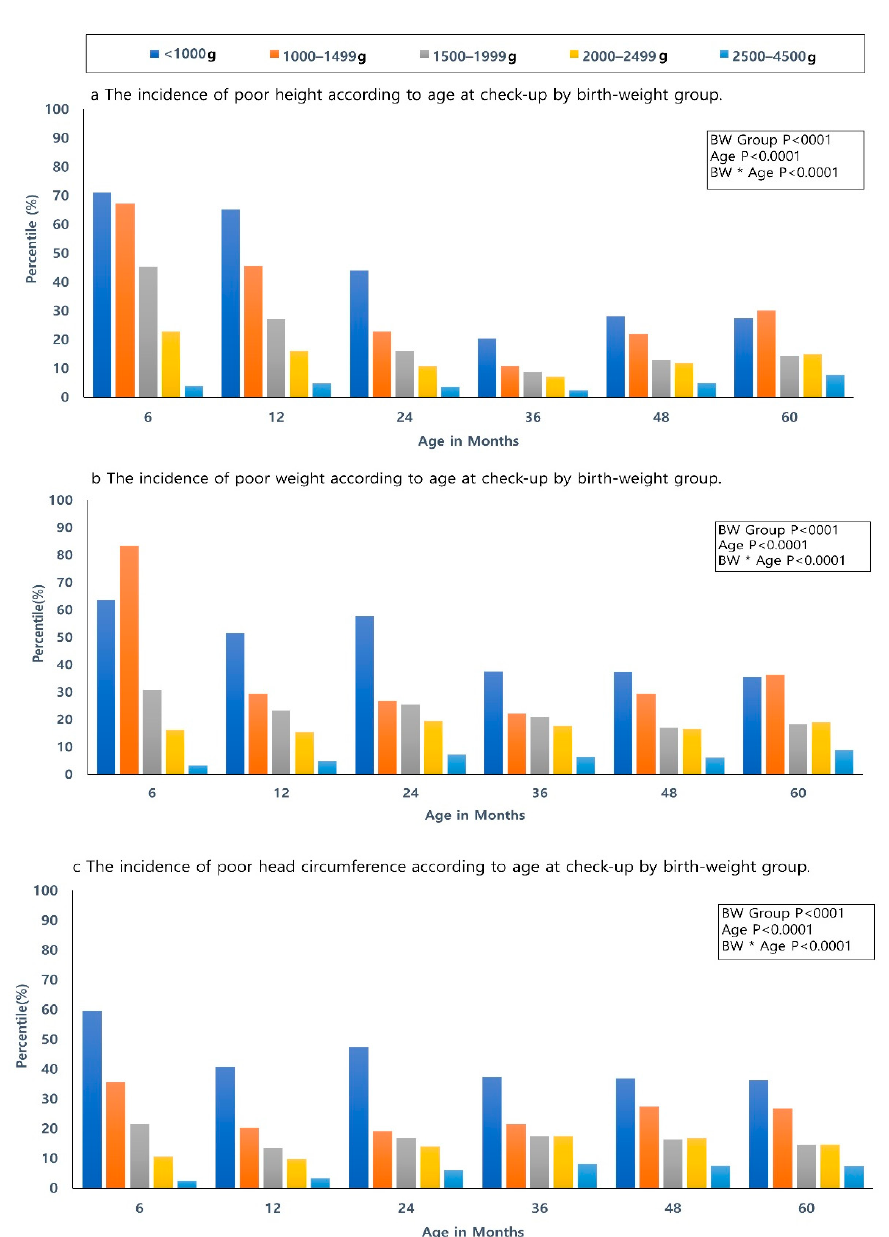
Figure 2. The incidence of poor growth (below 10th percentile) according to age at check-up by birth-weight group. ( a ) Height. ( b ) Weight. ( c ) Head circumference. A higher incidence of poor weight, height, and HC growth in the lower birth-weight groups was noted. A significant difference in height, weight, and HC between the low-birth-weight groups and the reference group according to age at health checkup were shown. p -values were significant in height, weight, and head circumference between each low-birth-weight group and the reference group compared at age of health check-up. The Pearson correlation coefficient of the growth percentiles (the height, weight, and HC percentile) at 6 and 60 months of age obtained using correlation analysis is shown as Figure 3. Figure 3a was the results for the whole study population. Among the infants below 1000 g of birth weight, only weight showed a highly positive correlation (coefficient = 0.72) between 6 and 60 months of age, height (coefficient = 0.65) and HC (coefficient = 0.64) showed a moderate positive correlation. Pearson correlation coefficient analysis between 6 and 60 months of age was performed only among the infants who fell below 10th percentile in terms of height, weight, and HC at 60 months of age, and the results were shown in Figure 3b. Among the infants below 1000 g of birth weight, weight, height, and HC showed a weakly positive correlation; otherwise, there was no association.